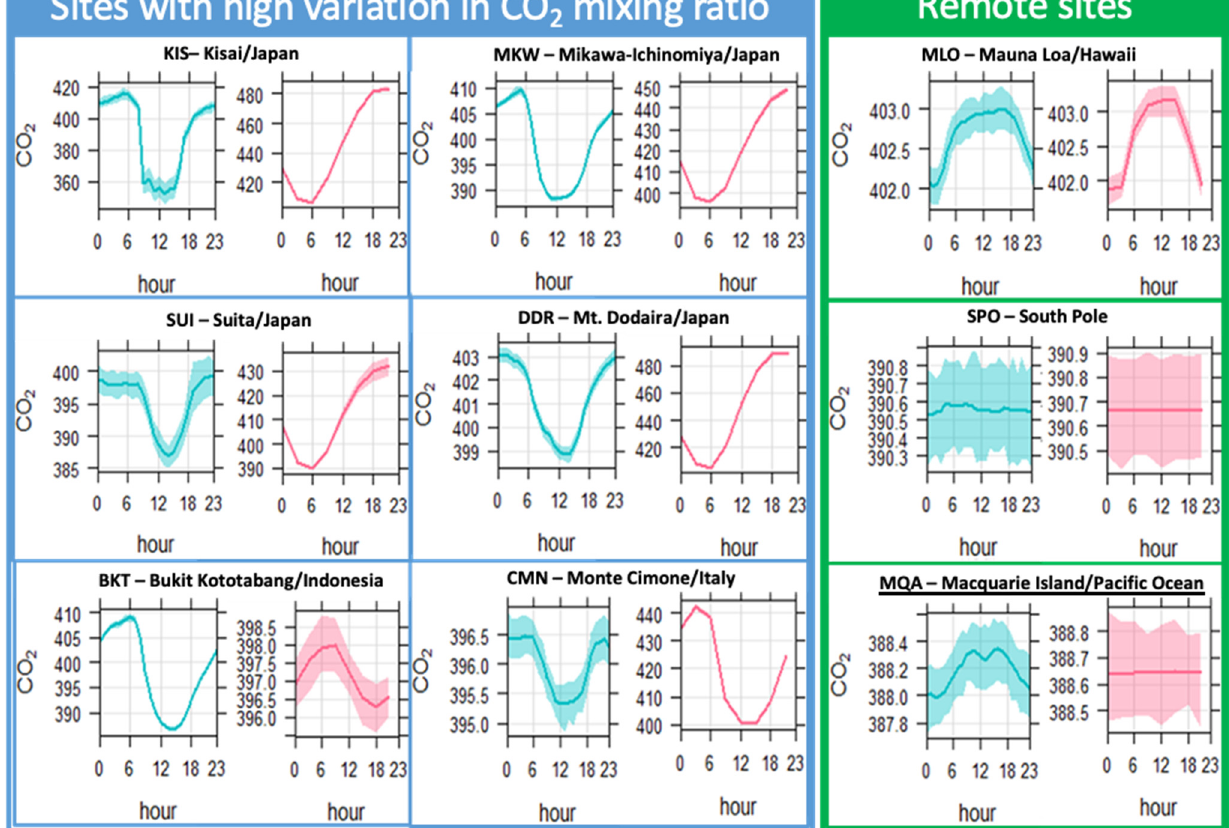
Figure 6. Diurnal cycle of CO 2 (in ppmv) displayed by the observation (light blue) and CAMS (red). The blue panel shows the diurnal cycle at six stations with high CO 2 mixing ratios variation; toward the left of the green panel, the diurnal variation at three remote stations with low CO 2 fluxes is shown. The smooth line represents the kernel average of the diurnal concentration of CO 2 , and the shaded area represents its variance in a 95% significance interval.